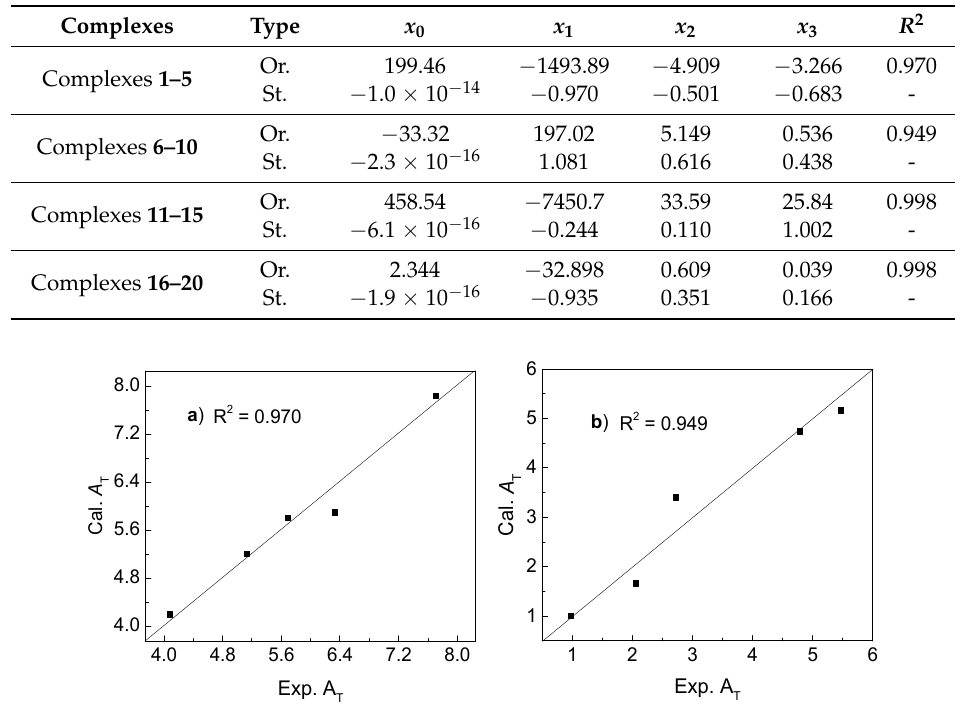
Figure 1. The plots of calculated value of thermal stability (Cal. A T ) versus experimental results (Exp. A T ) for complexes 1 – 5 ( a ) and complexes 6 – 10 ( b ). In the same manner, for complexes 6 – 10 , three parameters were obtained and listed in Table